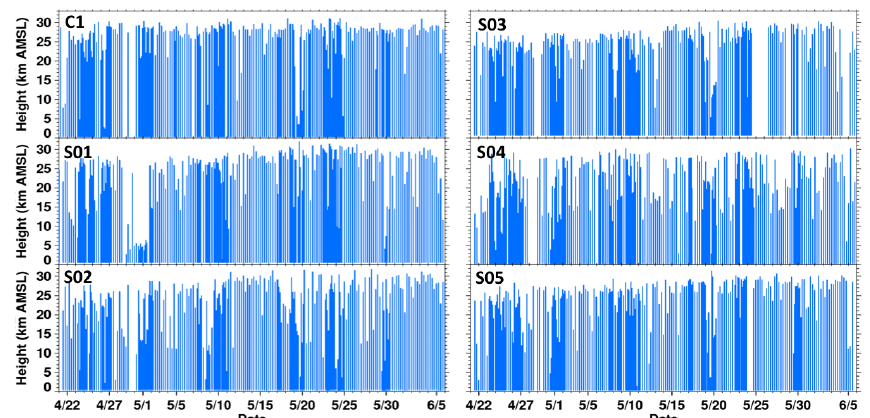
Figure 2. Sounding inventory summarizing the time of each launch and maximum height attained by each sonde for C1 (top), S1, S2, S3, S4, S5 (bottom).